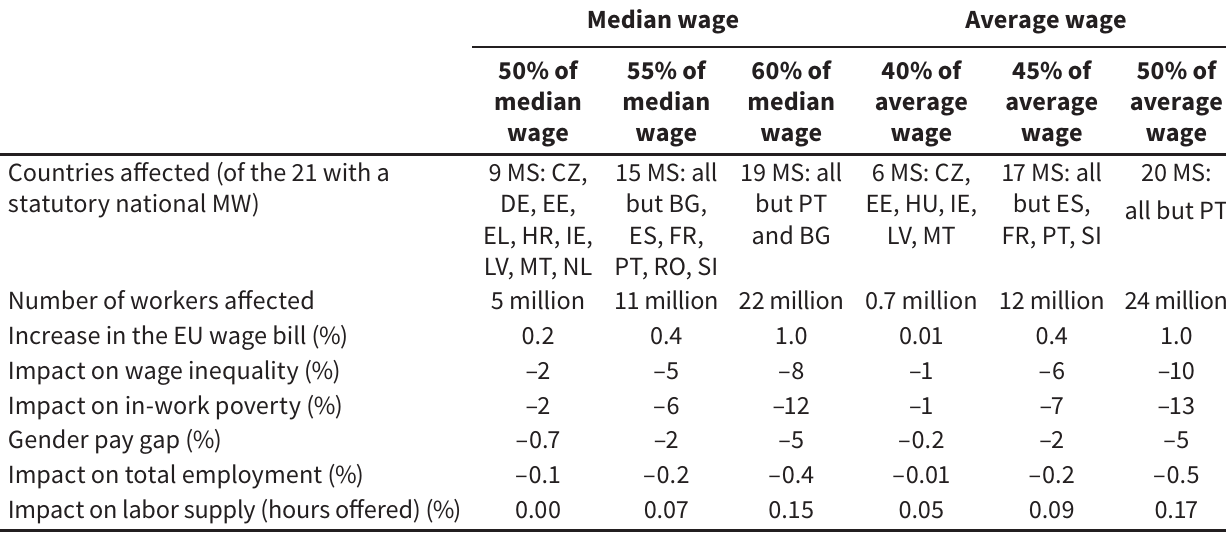
A summary of results at the EU level